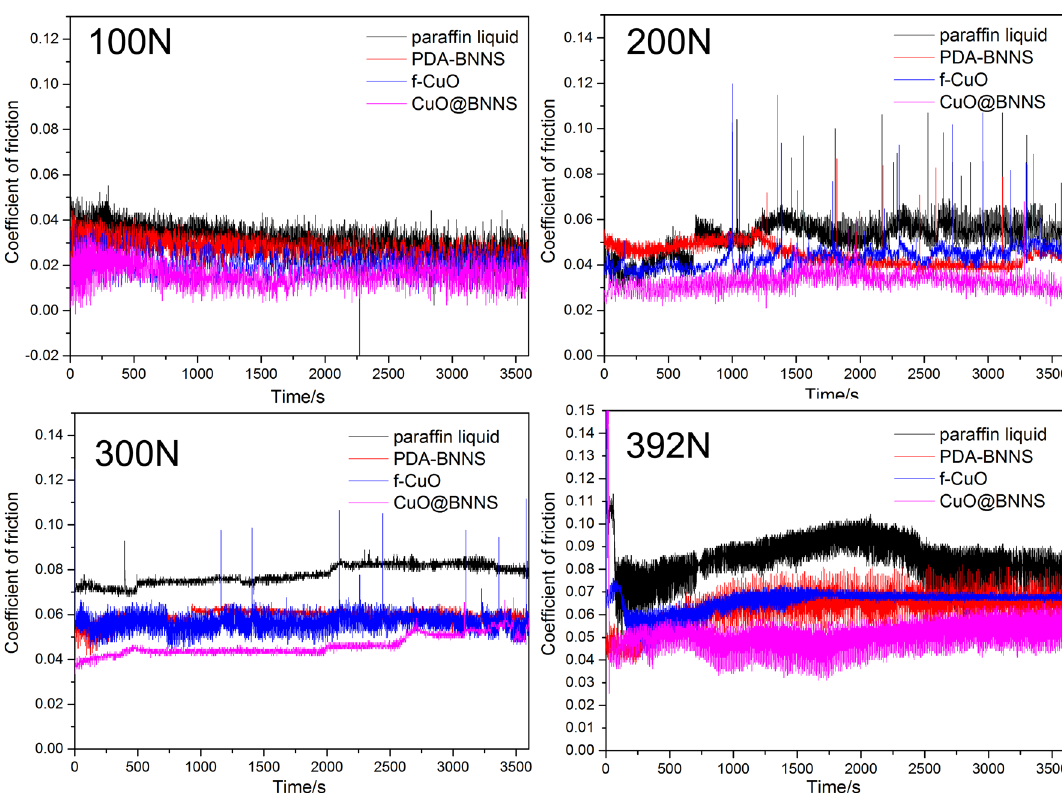
Fig.9 Coefficient of friction as function of test